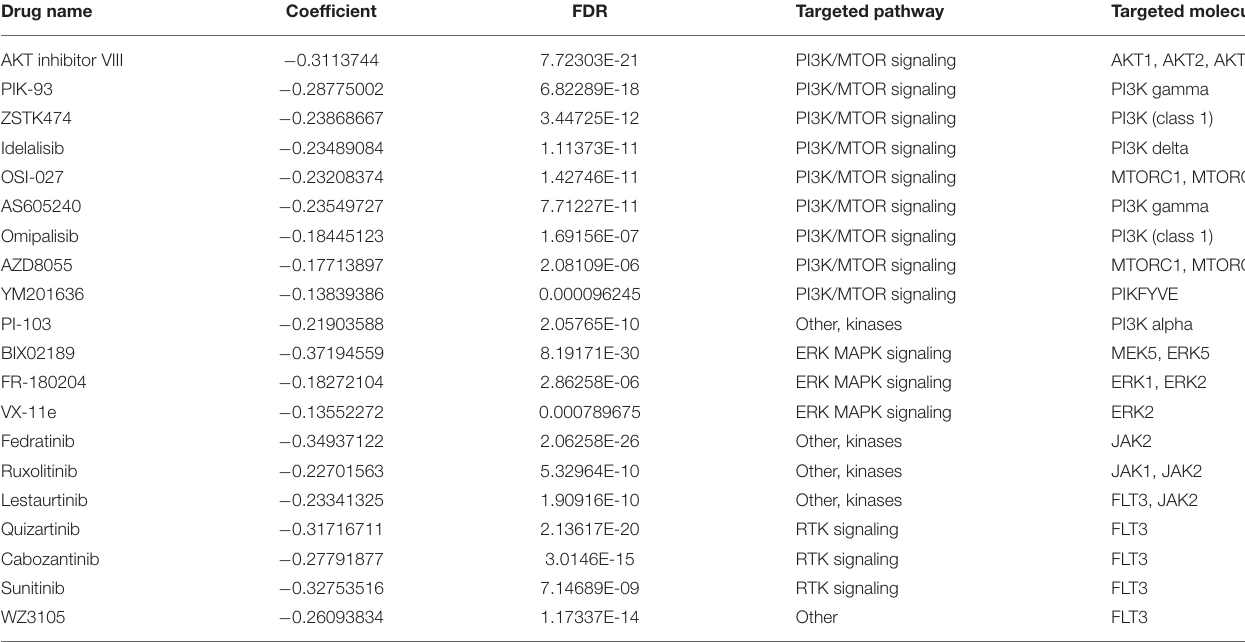
TABLE 4 | Associations between DOK2 expression and sensitivity to the drugs targeting DOK2-related pathways or molecules. Drug